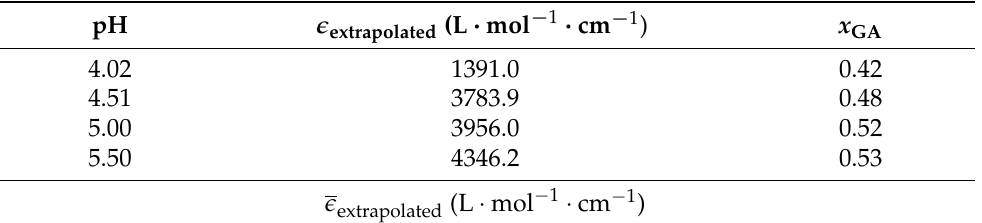
Table 1. The results of extrapolations of the Job plot curves for sample sets where c = 5 · 10 − 4 mol · L − 1